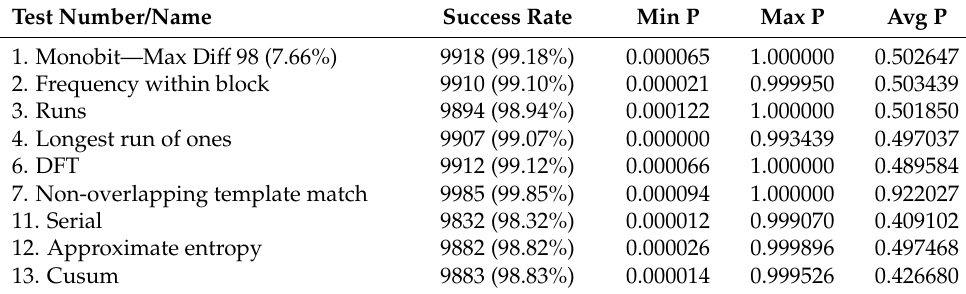
Table 4. Test results for the second variant random (10,000 samples